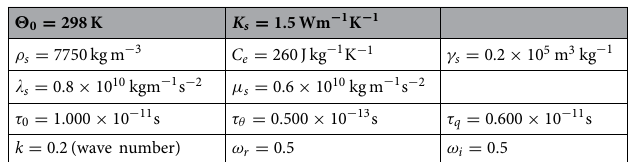
Table 2. Values of the geometrical and the material parameters for the